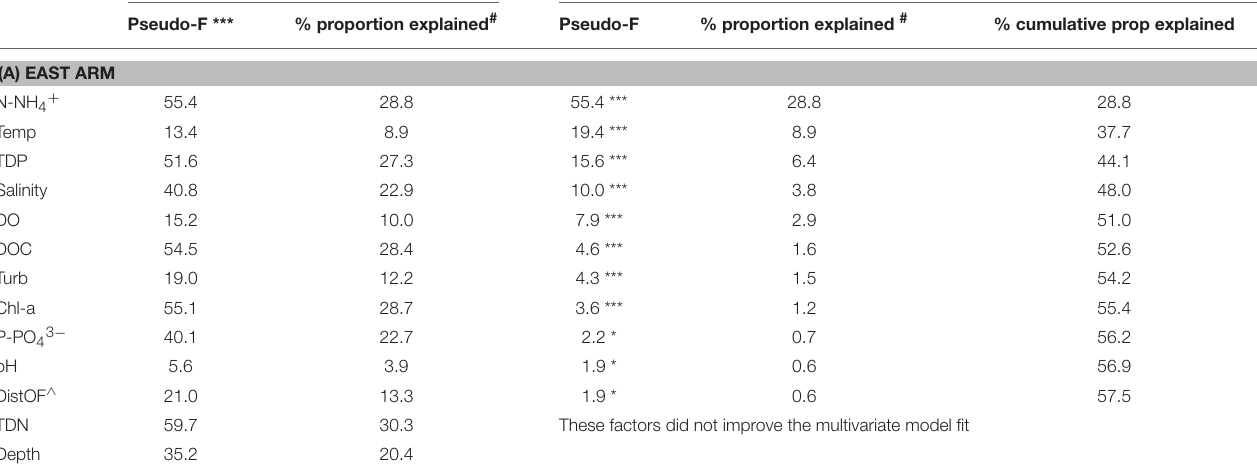
TABLE 2 | Abiotic factors and the water microbiota. Marginal test Sequential test accounting for other factors in the multivariate linear